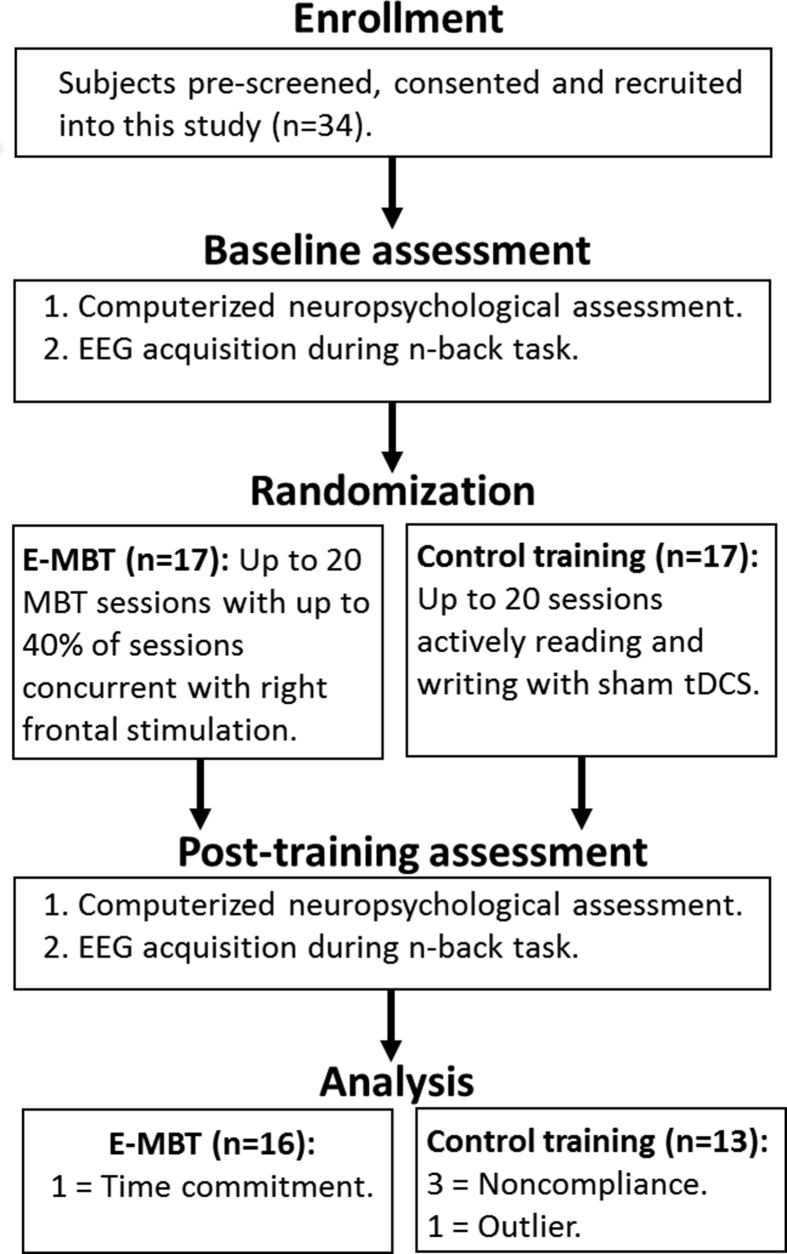
Flow Diagram of Study Methodology. Analysis boxes at bottom show number of subjects excluded for each group and reason for exclusion.